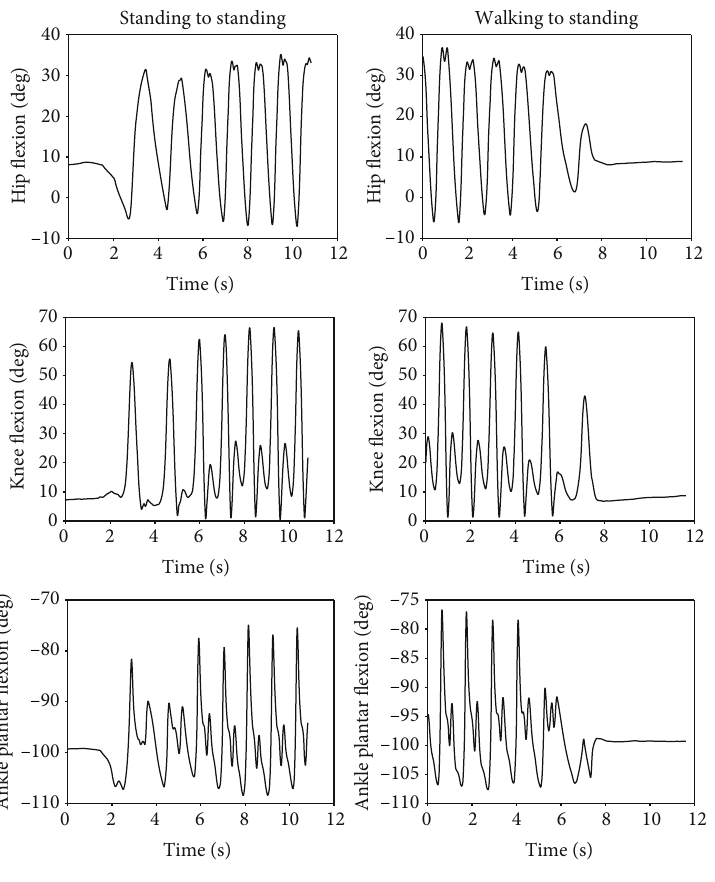
Figure 8: The left fi gures show the joint angles during the transition from standing to fast walking at 1.5m/s (trial 22), and the right fi gures show the transition from fast walking at 1.5m/s to standing (trial 25). These results are taken from subject AB02.